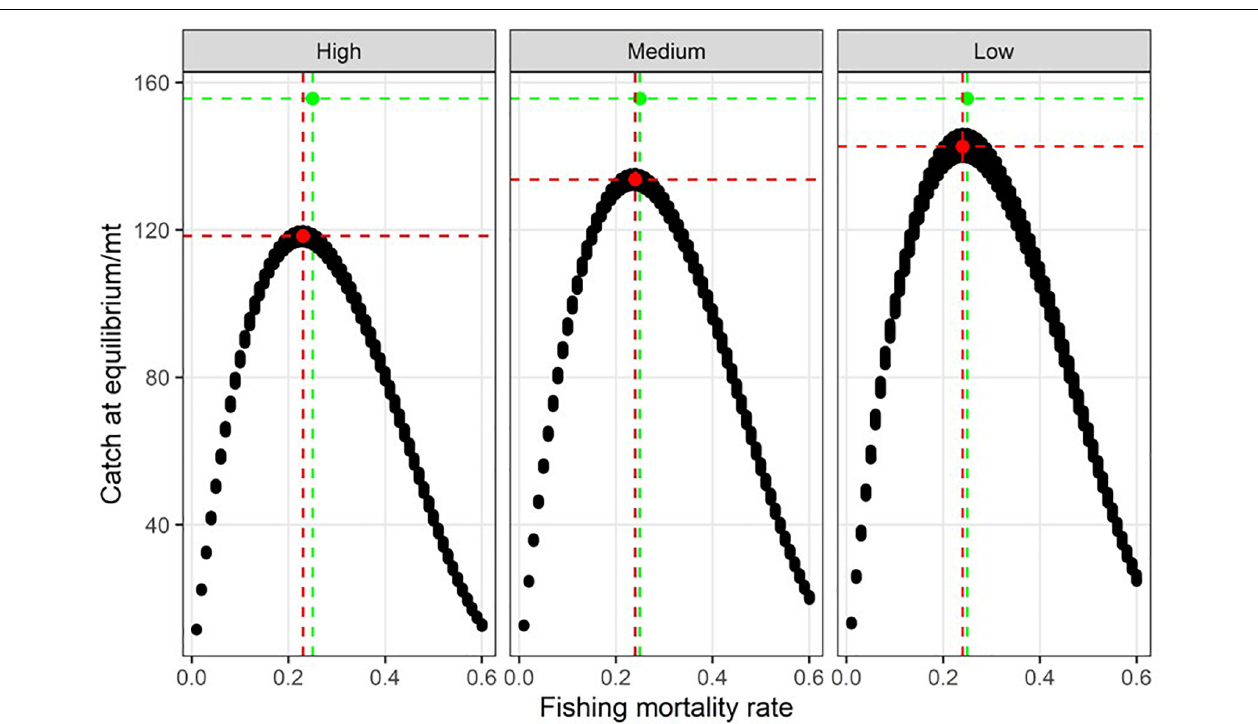
FIGURE 6 | Catch at equilibrium under different fishing mortality rates under different green tide bloom intensities. The red dots indicate the fitted F MSY and MSY for each scenario. The green dots indicate the F MSY and MSY for green tide-free scenario.